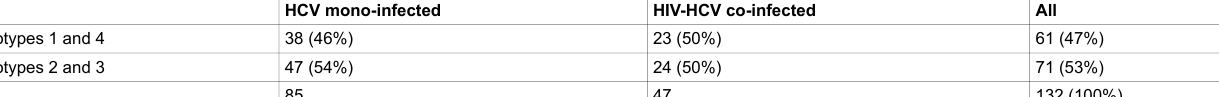
Table 1 Patient characteristics at baseline.